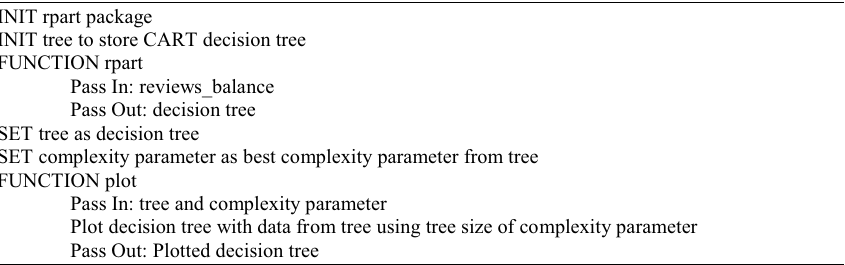
Table 6 Pseudocode to execute the CART Model and plot decision tree INIT rpart package INIT tree to store CART decision tree FUNCTION rpart Pass In: